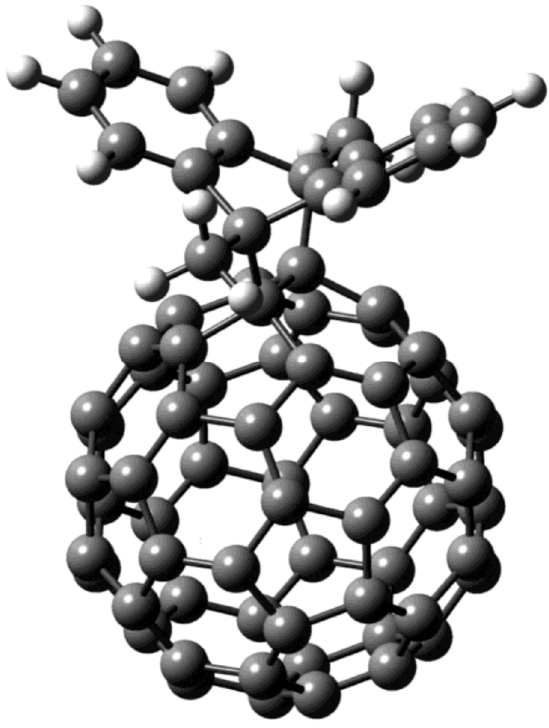
Figure 1. Gauss view of mono-adduct of DMA and C 60 .